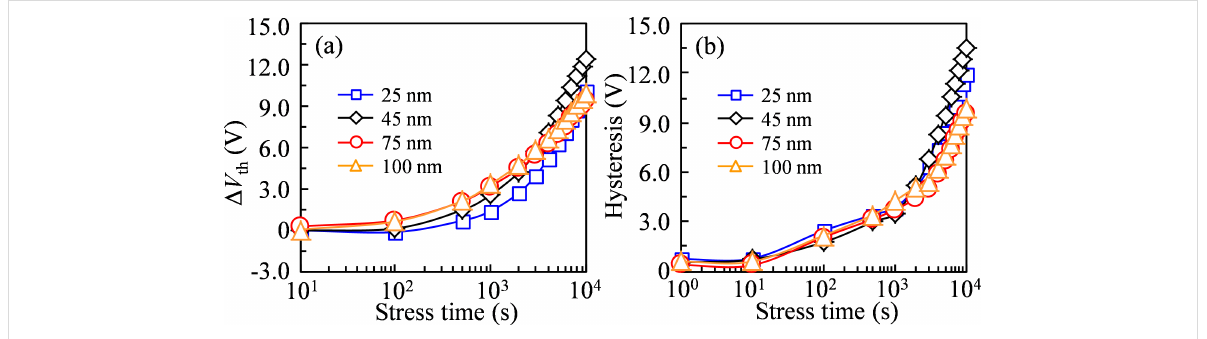
Figure 4: (a) Variation in V th of the transfer curves of a-IGZO TFTs with various T IGZO in the reverse measurement as a function of NBIS duration and (b) hysteresis of a-IGZO TFTs with various T IGZO as a function of NBIS duration.